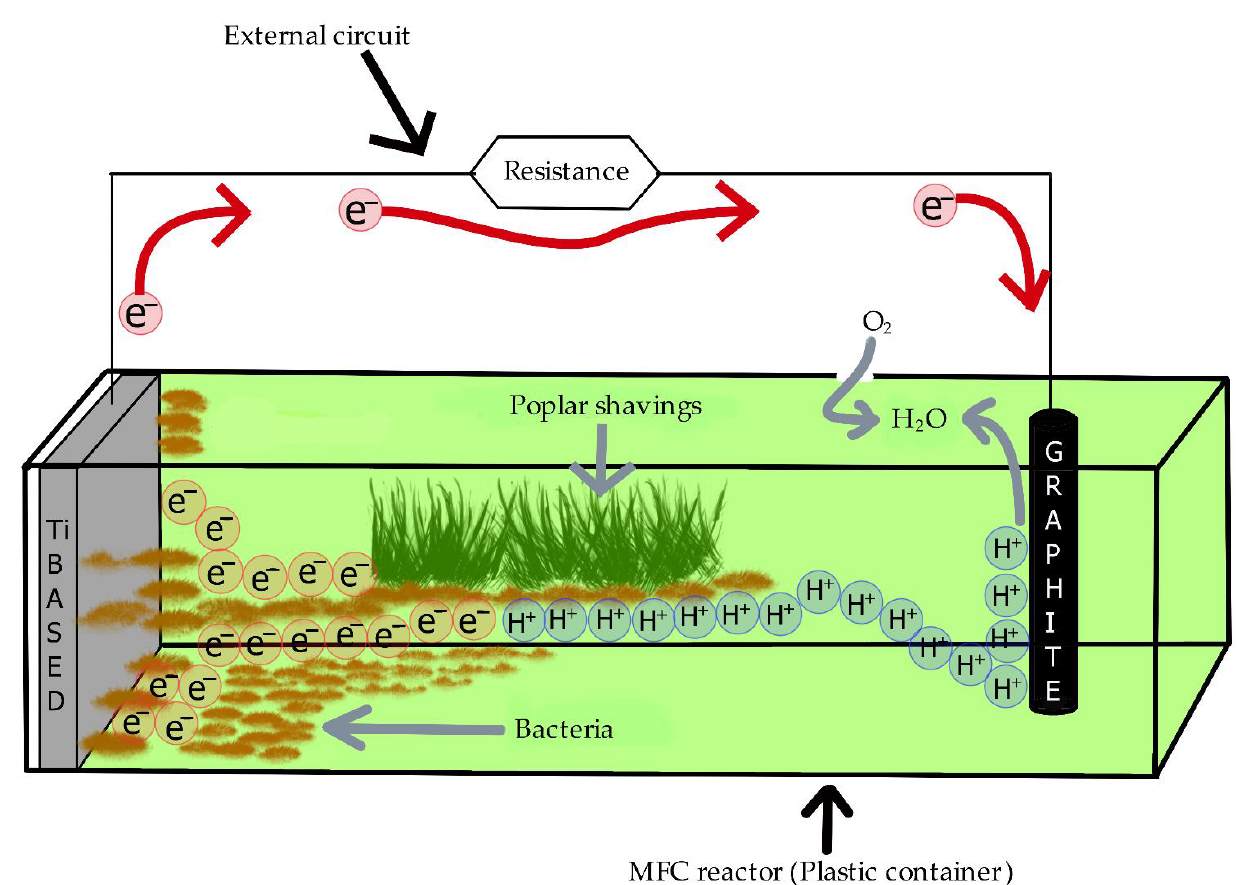
Figure 8. Working principle of poplar substrate-based MFCs.